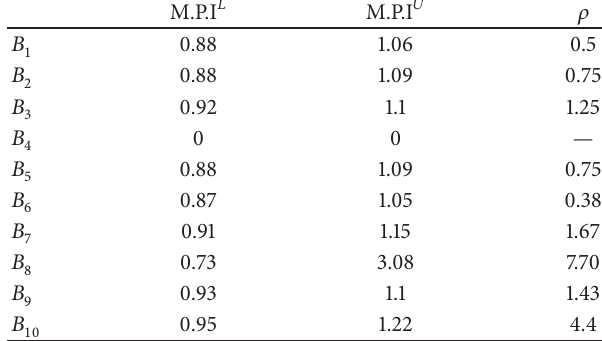
Table 15: 𝑆 and 𝑅 interval numbers (year of 2005-year of 2004).